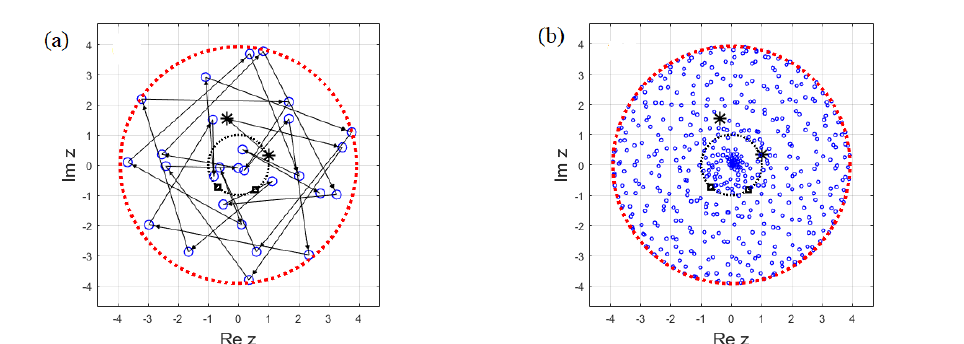
computed by (1), for ( a ) N = 30 n = 0